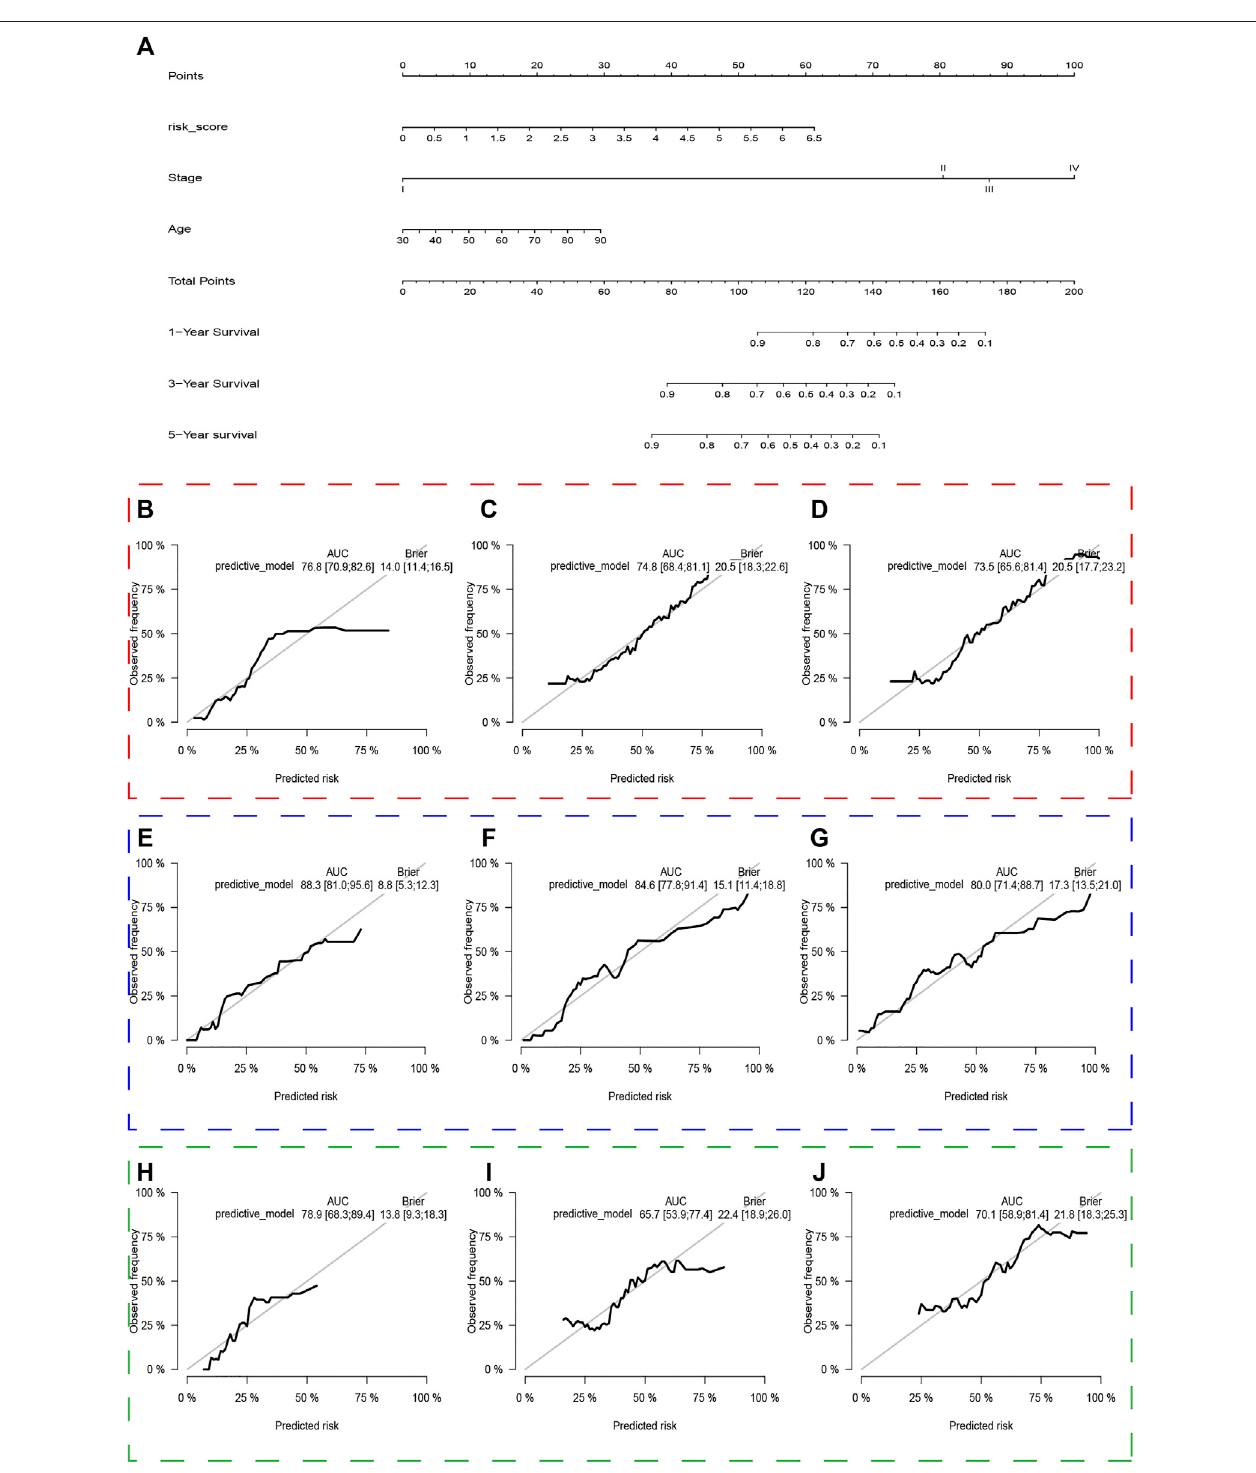
FIGURE 12 | The nomogram of the UPR-related gene signature and its performance in the training set, and external validation sets. The predictive model was presented with a nomogram (A) . The red, blue and green dashed boxes corresponded to the TCGA dataset, GSE13507, and GSE48075. The AUC and Brier scores of the nomogram in years 1, 3, and 5 in the training set (B – D) , GSE13507 (E – G) , and GSE48075 (H – J) .